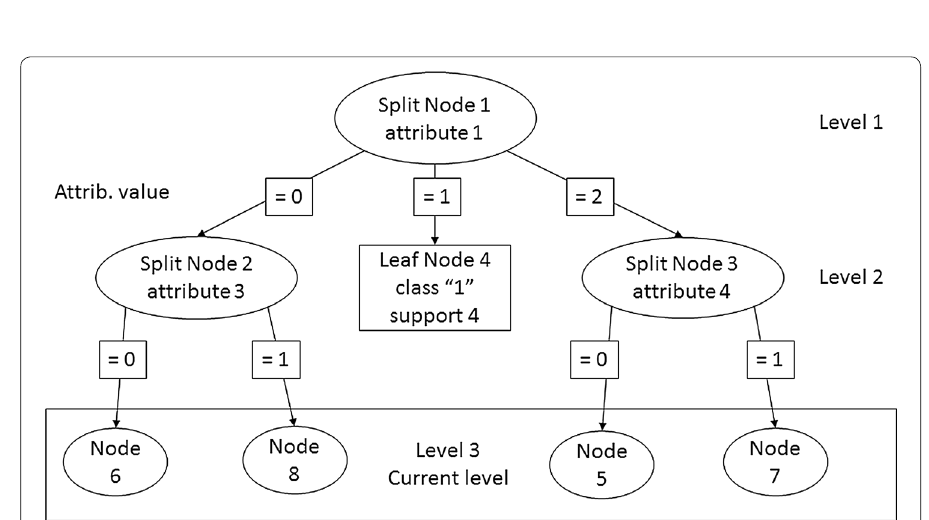
Fig. 17 Decision Tree at the end of iteration